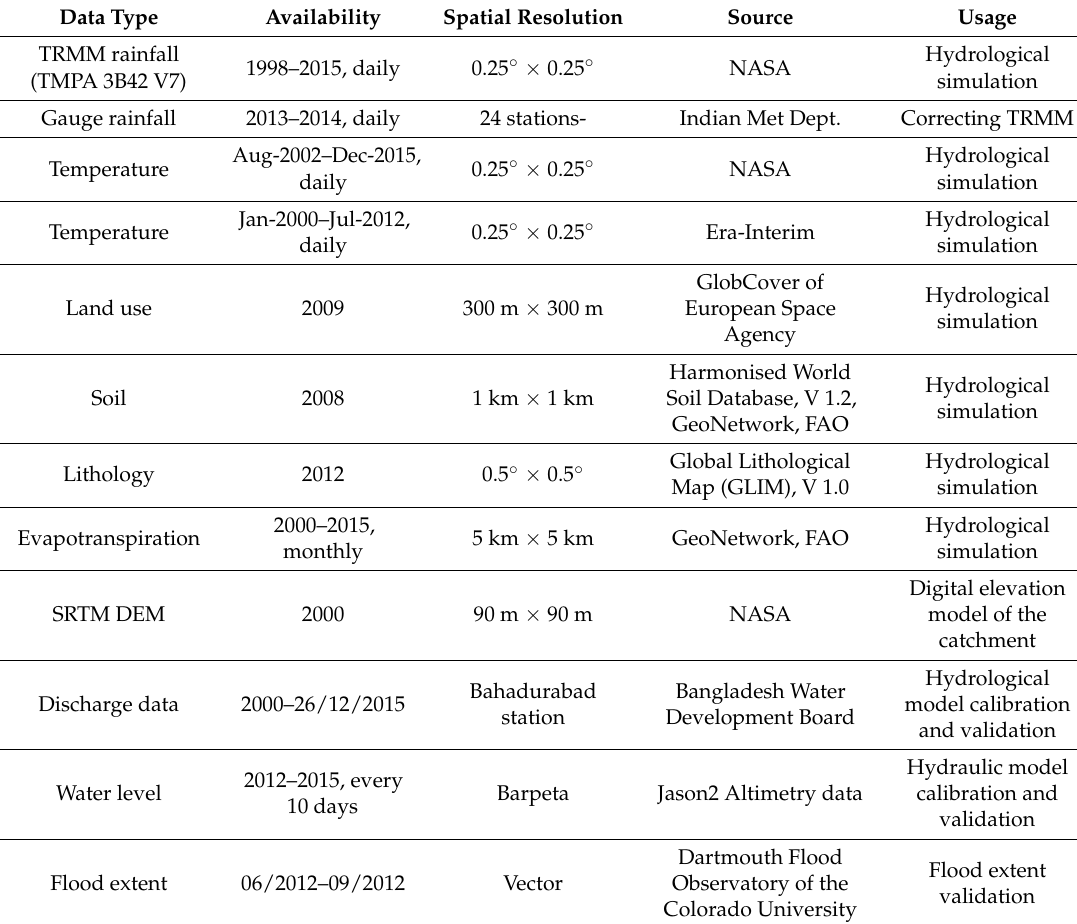
Table 1. List of data used in the